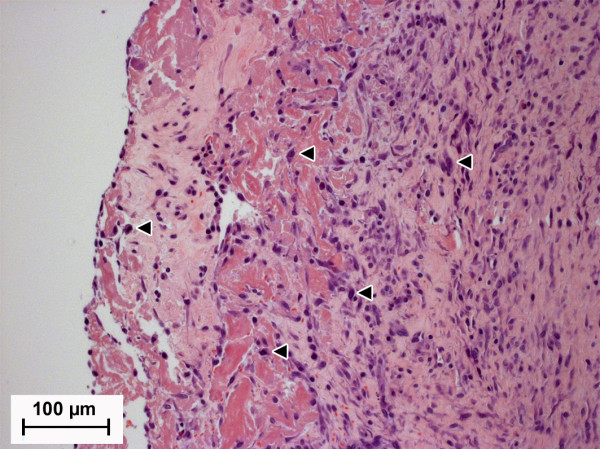
Image section of an S316L implant site two weeks postoperatively showing moderate necrosis and mild infiltration with macrophages within a moderately developed fibrous layer (H. E., 200×). The area of necrosis at the edge of the fibrous tissue is clearly observable. Macrophages are exemplarily represented by triangles.